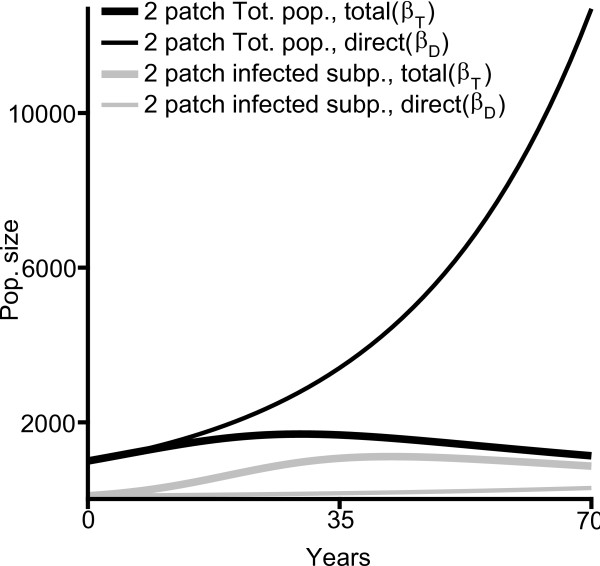
HIV prevalence in a cofactor free population. 35 year population time series for two-patch model with total transmission rate (βT , thick lines) and two-patch model with direct transmission rate (βD, thin lines). Total populations indicated in black, infected subpopulations in gray. Starting conditions: 1000 individuals, 100 infected by the primary disease, 0 carrying the cofactor.